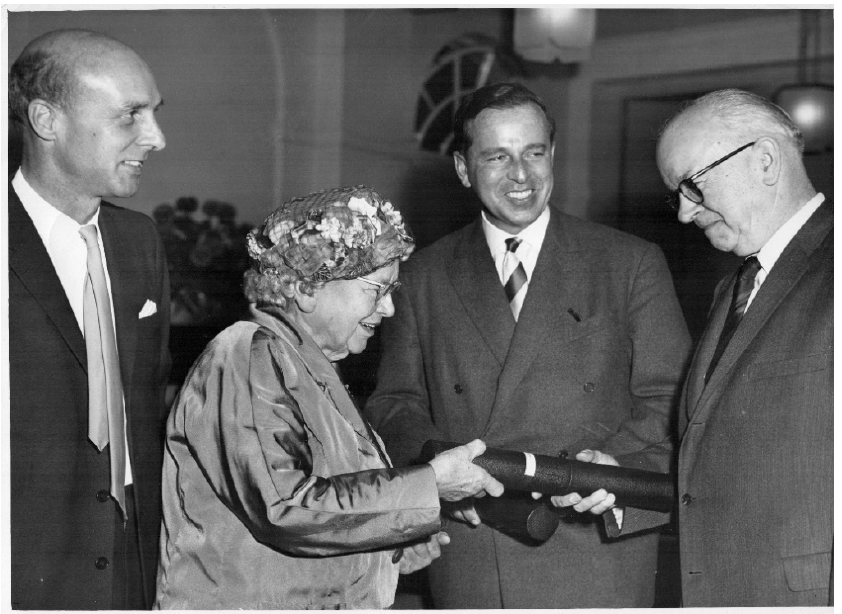
Figure 7. Dr. Evelyn Hickmans with Professor John Gerrard (left) and Professor Horst Bickel (right) receiving the John Scott Award from Dr. W Greulich, Scientific attaché to the US Embassy in London: Birmingham 1962.